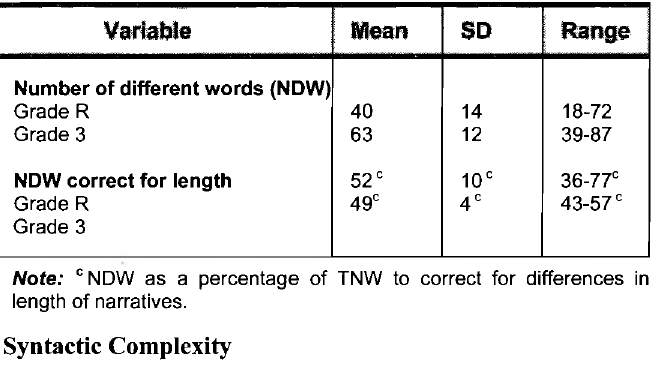
Table 3: Means, standard deviations and ranges of number of differ­ ent words (NDW) elicited in story retell narratives Variable